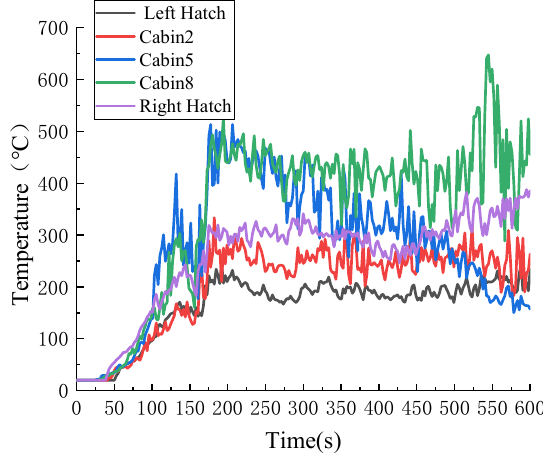
Figure 5. Temperature change curve.